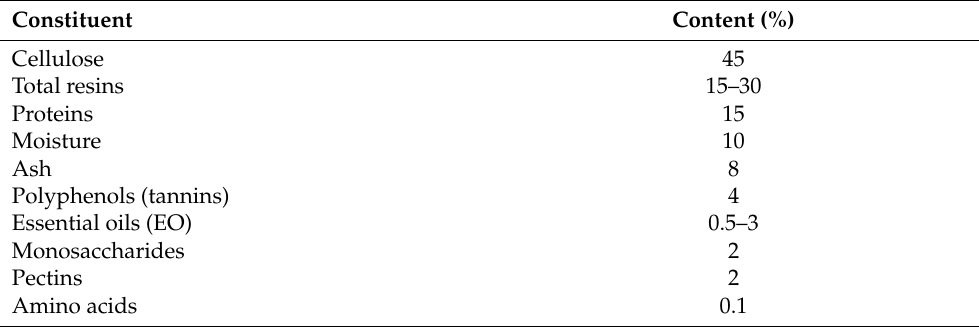
Table 1. Average chemical composition of dried hop